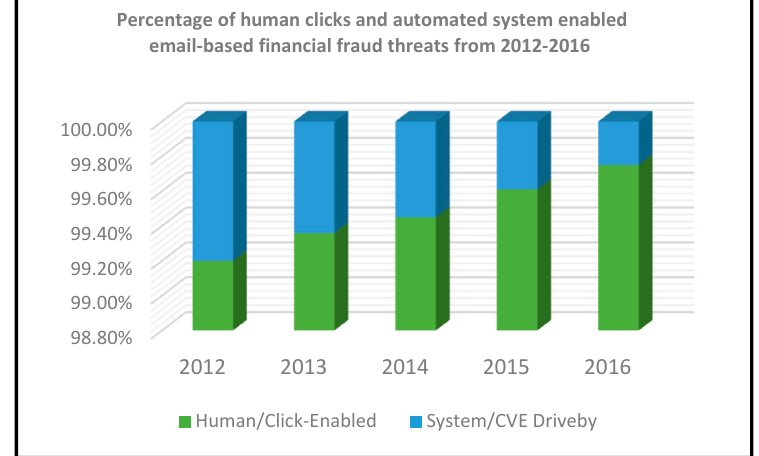
Figure 4. Percentage of human clicks and automated systems enabled by email-based financial fraud threats between 2012–2016 [26].